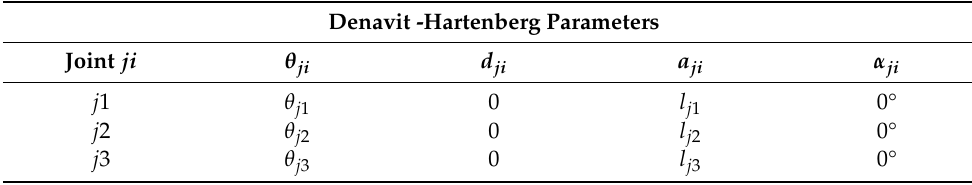
Table A7. Denavit–Hartenberg parameters for fingers I to V according to the newly introduced simplified hand model. Joint angle θ ji , joint distance d ji , link length a ji and link twist angle α ji for joint axis ji with finger number j and joint number i .